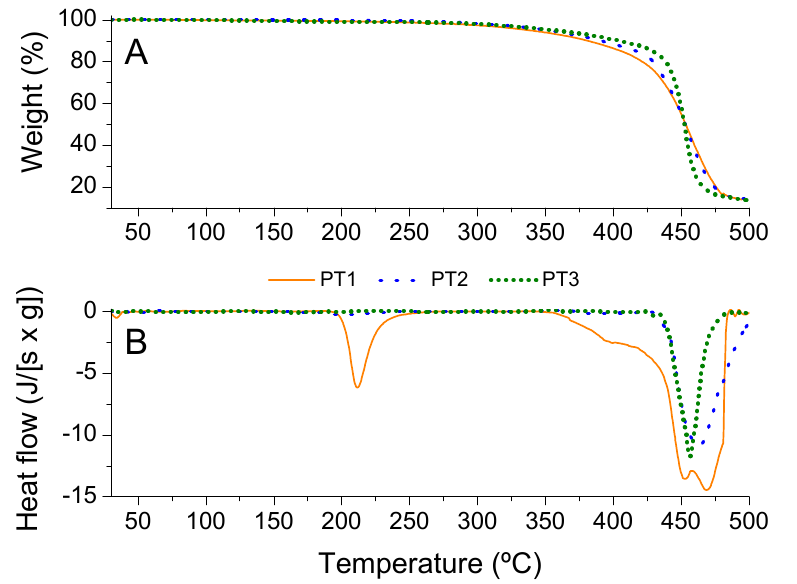
Figure 3. Thermal analysis of printed pieces submitted to post-treatment strategies PT1, PT2 and PT3: ( A ) Thermogravimetric analysis TGA ( B ) Differential Scanning Calorimetry DSC.